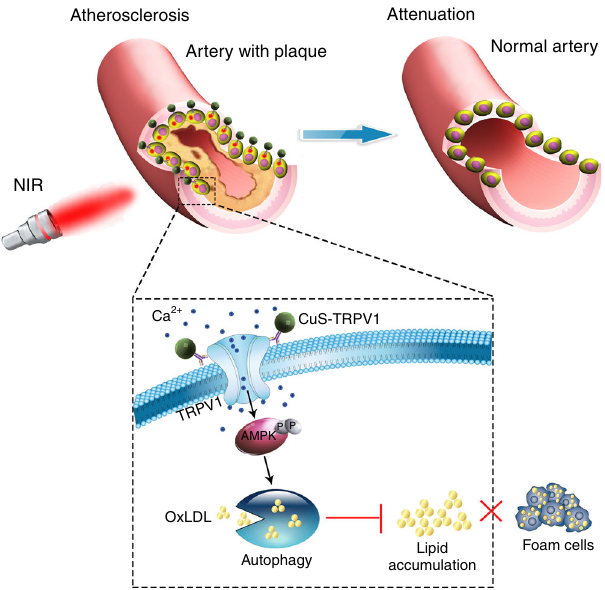
Fig. 1 Illustration of CuS-TRPV1 switch for photothermal activation of TRPV1 signaling to attenuate